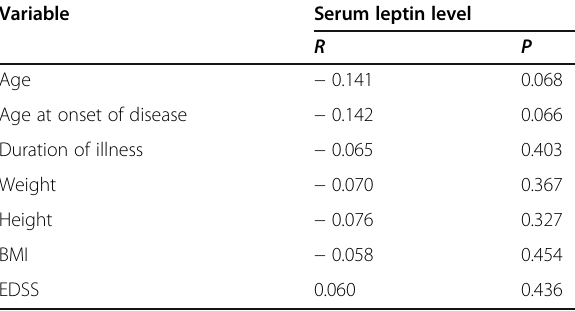
Table 4 Correlations between serum leptin level and the clinical characteristics of the